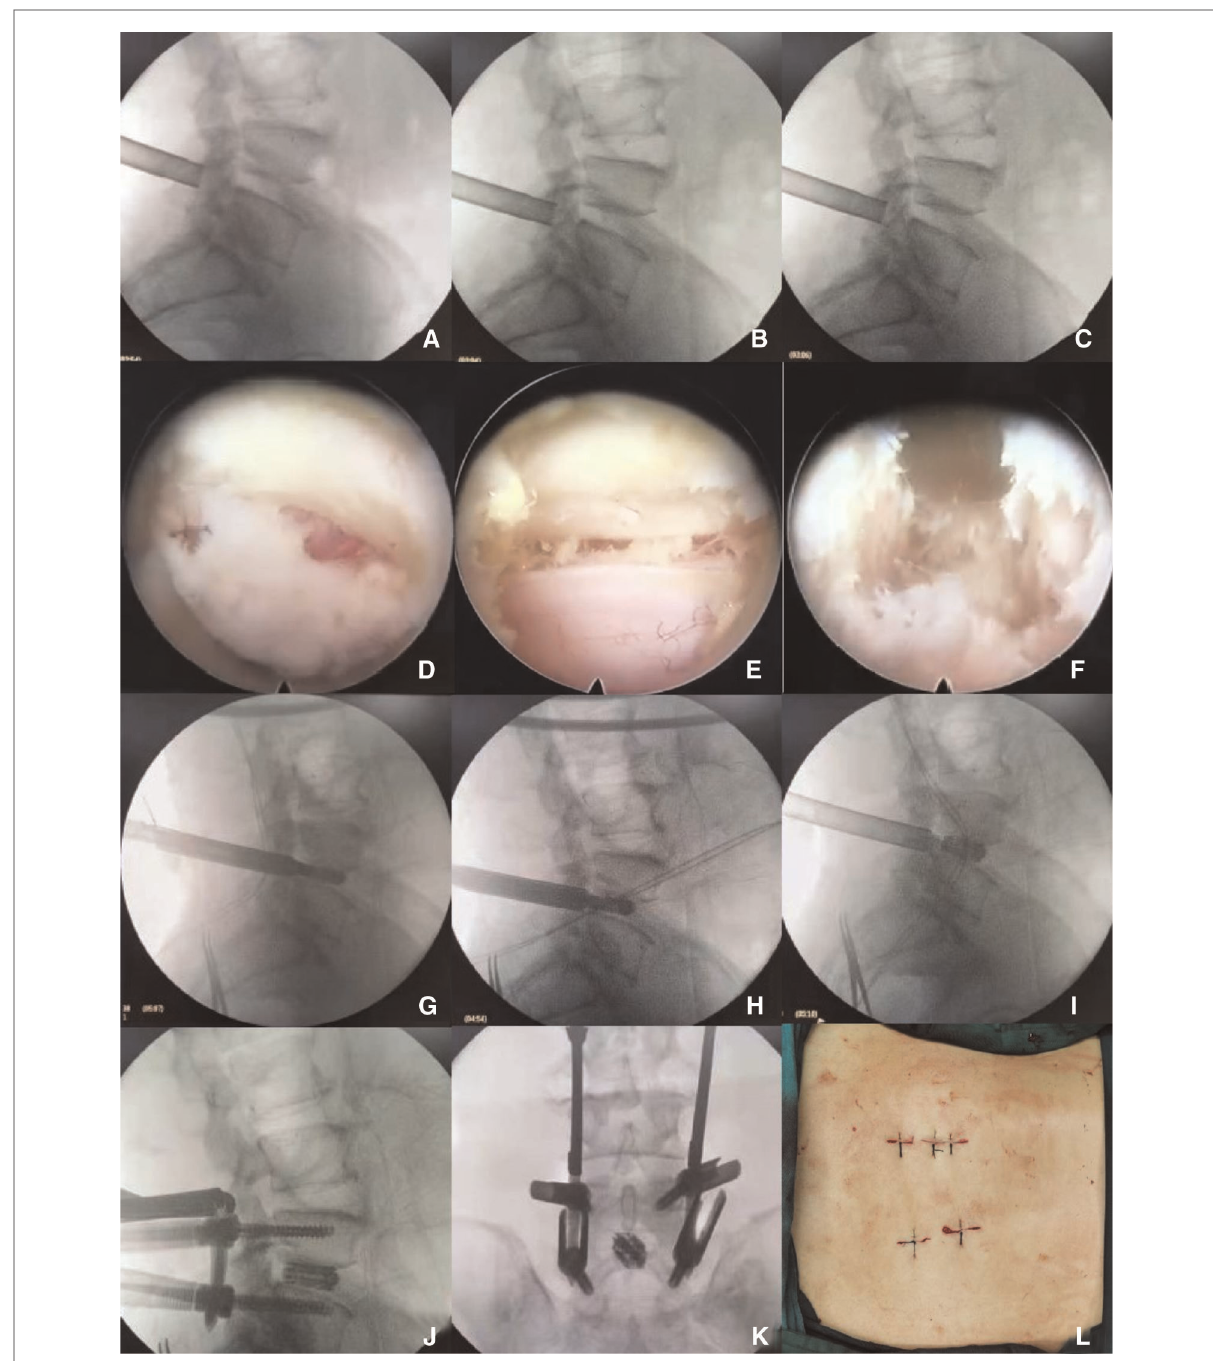
FIGURE 1 ( A – C ) show that the lumbar vertebrae of Endo-LIF operation were successfully punctured laterally, and the inferior articular process was removed by fl uoroscopic saw ring; ( D – F ) were performed under Endo-LIF operation microscope; ( G – I ) were implanted with Endo-LIF fusion cage; ( J )